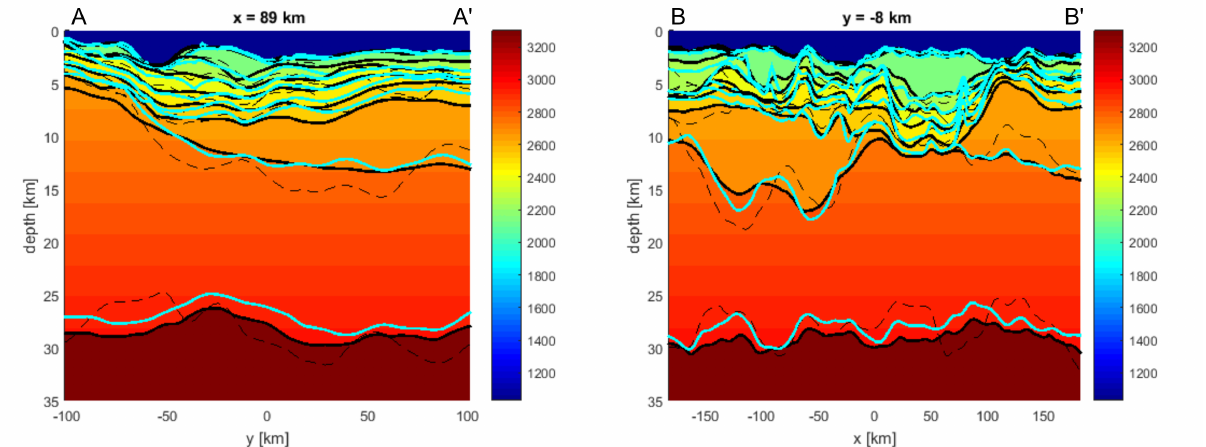
Figure 12. Example of two profiles (AA’ and BB’ in Figure 1) of the estimated model for Scenario 2 inversion. Cyan lines represent the geological horizons of the true model, black lines represent the horizons estimated by the inversion, dashed black lines represent the horizons of the a priori model and colours represent density in kg/m 3